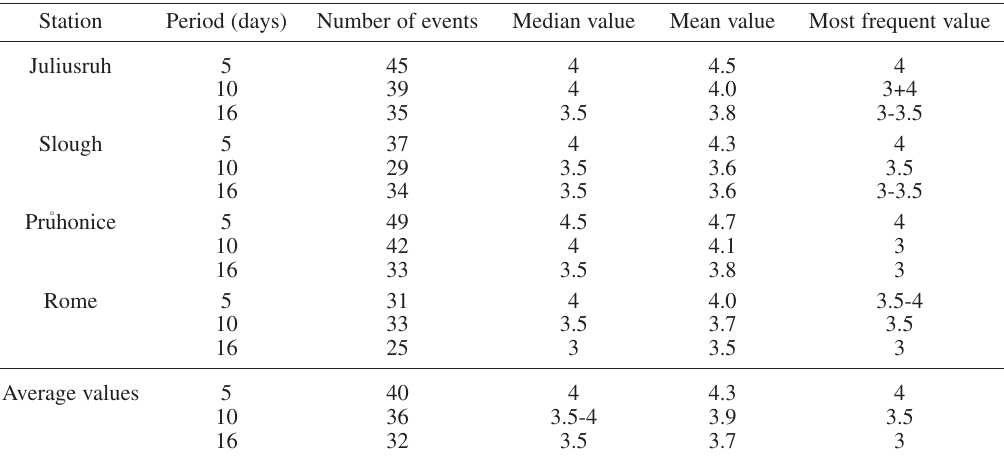
Table V. Statistics of persistence of planetary wave type oscillations in foF 2 over Europe based on the Morlet wavelet transform (relative values). The average values for medians and the most frequent values are presented with a step of 0.5. After Lasˇtovicˇka et al.